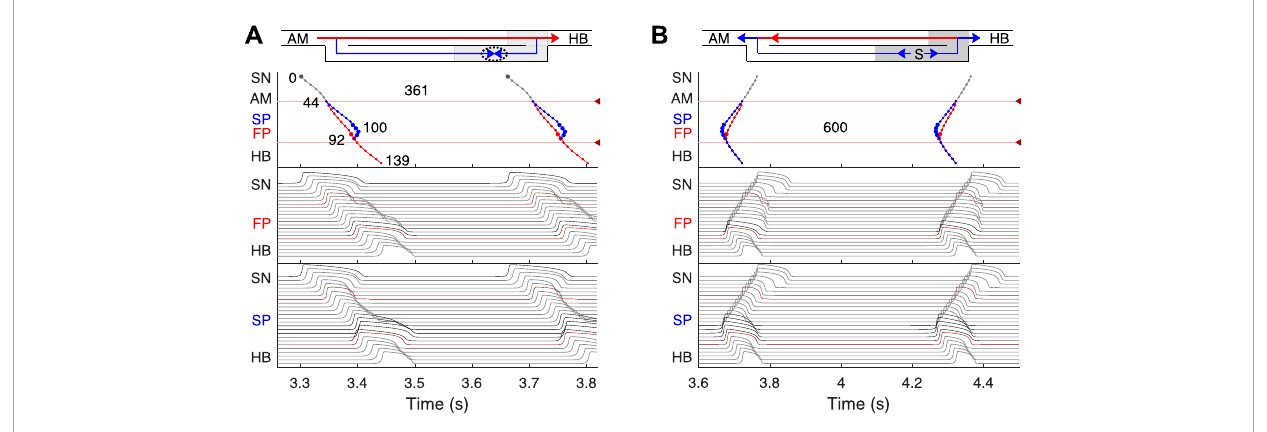
FIGURE 4 Primary and subsidiary pacemaking. Here and after top scheme illustrates propagation conduction sequences of interacting fast (FP, red arrows) and slow (SP, blue arrows) pathways. Top panel : the laddergram (Lewis ladder diagram) with the exact timing of each model cell excitation. Smaller circles denote quiescent excitable model cells, and larger circles - natural pacemaker cells. Red and blue traces correspond to the propagation through the FP and SP, respectively. The trace color in the HB part corresponds to the leading pathway. Dark red arrowhead markers on the right side and the adjacent lines denote the points of latency time measurements. Middle panel : the sequence of action potentials passing through the FP between the SN and HB. Bottom panel : the sequence of action potentials passing through the SP between the SN and HB. Action potentials in red correspond to the latency time measurement points, and in black color - to the pacemaking cells. Time scale is common for all three panels. (A) Rabbit’s normal sinus rhythm of 166 bpm (361 ms interval). The numbers on the traces indicate excitation wave latency with respect to the SN in milliseconds. (B) In the case of a silent SN pacemaker, the spontaneous activity with 100 bpm rate (600 ms interval) originates in the SP.